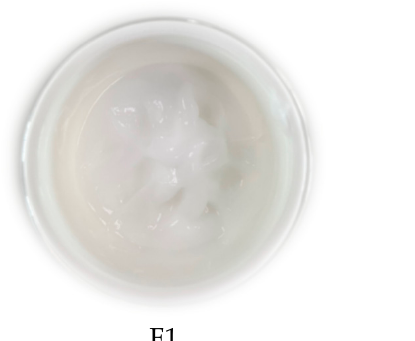
Figure 2. The appearance of liquid crystal creams: without (F1) and with germinated brown rice extract (F2).